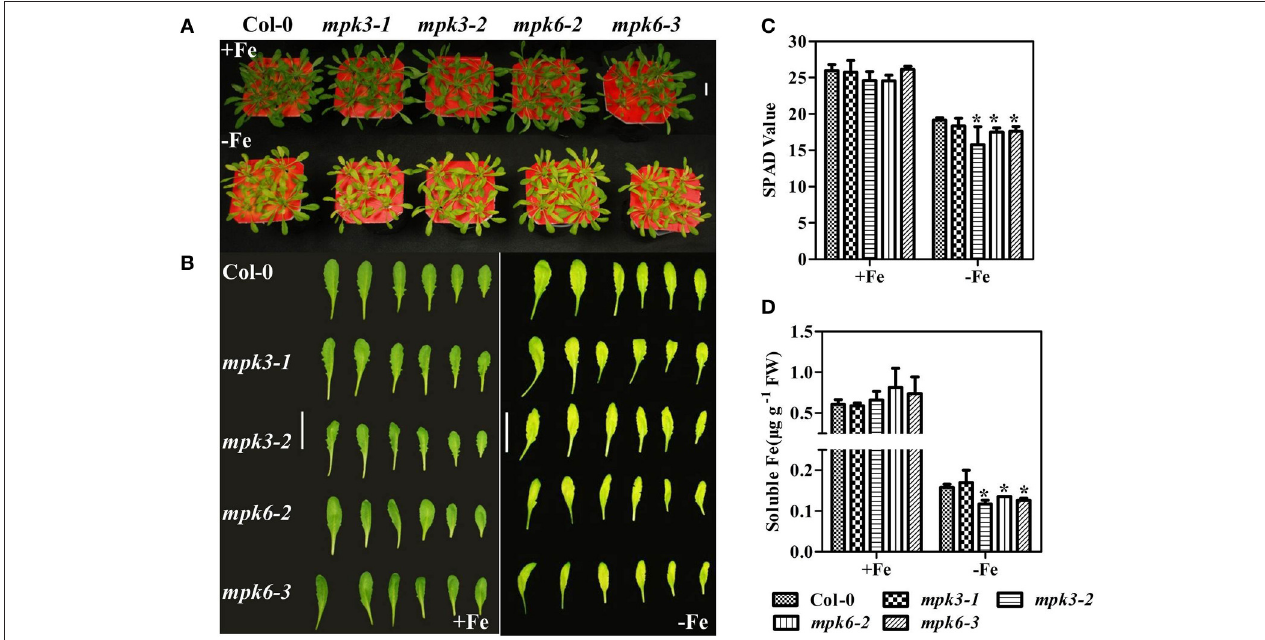
FIGURE 7 | Phenotypes of mpk3 and mpk6 mutants grown in Fe-sufficient or Fe-deficient conditions. (A) Growth performance of WT, mpk3 , and mpk6 mutant plants. 30 day-old seedlings were grown in Fe -sufficient (50 µ M) or -deficient (0 µ M) nutrient solution for 7 days. (B) Young leaves (from the third to the eighth) were detached to display their phenotypes. (C) SPAD values of WT, mpk3 , and mpk6 mutants. (D) Soluble Fe concentration of WT, mpk3 , and mpk6 mutants. Scale bar = 3cm. Data are shown as the mean ± SEM ( n = 3 ). Column marked with “ * ” indicate a significant difference ( P < 0.05 ).